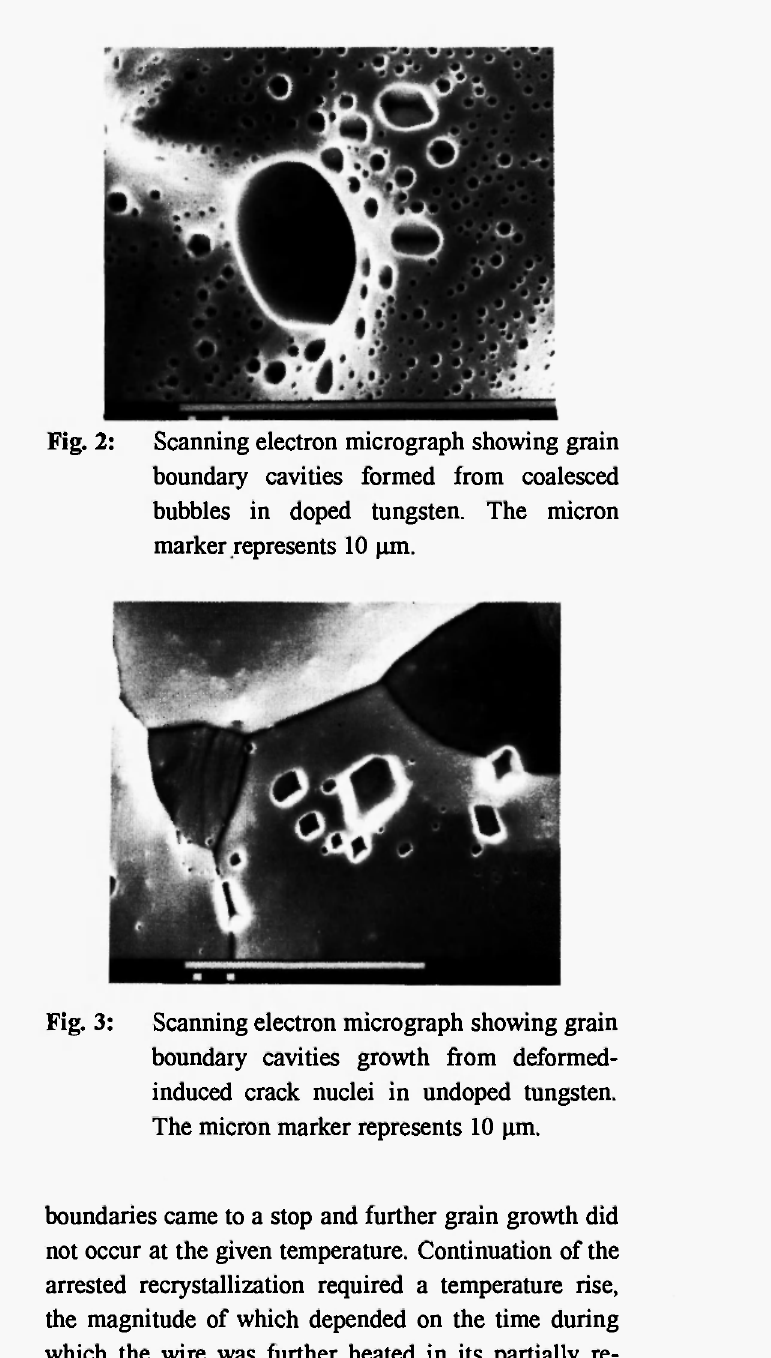
Fig. 3: Scanning electron micrograph showing grain boundary cavities growth from deformed- induced crack nuclei in undoped tungsten. The micron marker represents 10